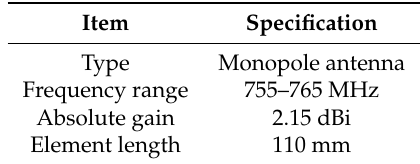
Table 3. Antenna